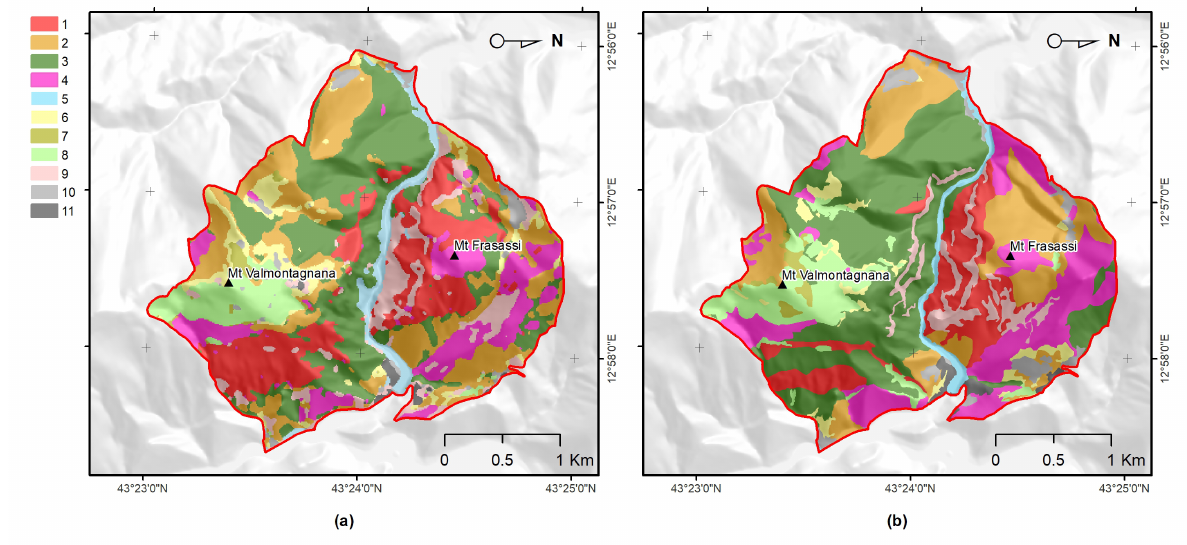
Figure 3. Plant associations and habitat maps of SAC “Gola di Frasassi” —code IT5320003 (Central Italy): ( a ) Map obtained by the supervised random forest classification of the main seasonal remotely sensed phenological variations as well as the main topographic and lithological predictors; and ( b ) map derived from the SIT-REM of Marche region [72] produced by experts through the photo- interpretation phytosociological traditional method . Legend numbers correspond to the plant associations and habitats listed in Table